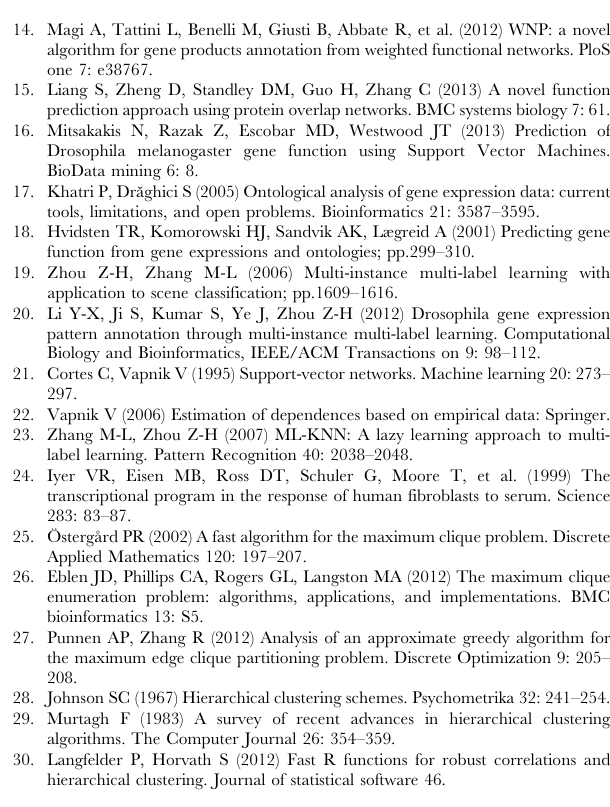
Figure S5 ROC curves are obtained from alpha dataset by MLSVM. The ROC curves of each learning system, generated by average TPR and FPR, as well as the four subplots (a), (b), (c), and (d) with parameter n% =20%, 40%, 60%, and 80%, respectively, are displayed. (TIF) Figure S6 ROC curves are obtained from alpha dataset by MLKNN. The ROC curves of each learning system, generated by average TPR and FPR, as well as the four subplots (a), (b), (c), and (d) with parameter n% =20%, 40%, 60%, and 80%, respectively, are presented. (TIF) Figure S7 ROC curves are obtained from elution dataset by MLSVM. The ROC curves of each learning system, generated by average TPR and FPR, as well as the four subplots (a), (b), (c), and (d) with parameter n% =20%, 40%, 60%, and 80%, respectively, are shown. (TIF) Figure S8 ROC curves are obtained from elution dataset by MLKNN. The ROC curves of each learning system, generated by average TPR and FPR, as well as the four subplots (a), (b), (c), and (d) with parameter n% =20%, 40%, 60%, and 80%, respectively, are displayed. (TIF) Table S1 Number of positive and negative samples in MIHC from the cdc28 dataset. (XLS) Table S2 Number of positive and negative samples in MIHC from the elution dataset.